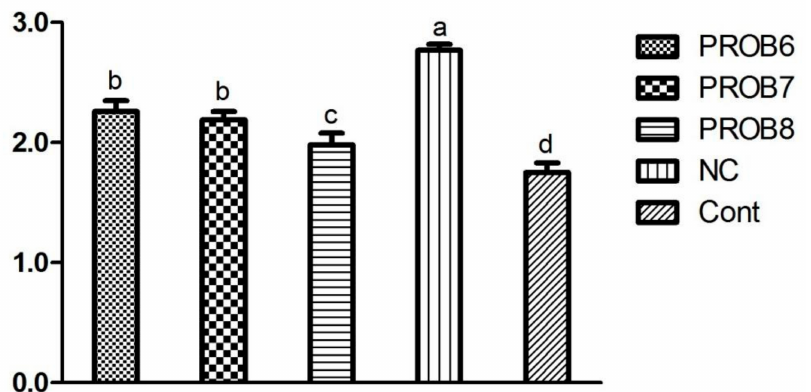
Figure 3. Feed conversion ratio (FCR) in chickens with experimentally induced coccidiosis in different treated groups. Means with different superscripts (a, b, c, d) are significantly different ( p <